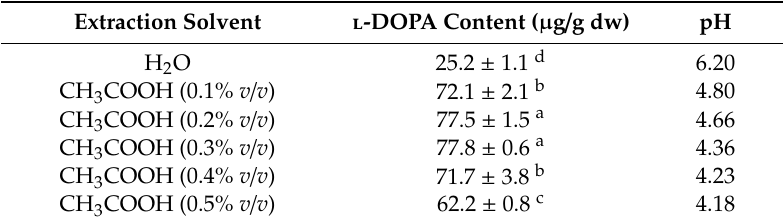
Table 1. Efficiency of L -DOPA extraction A from dry beans of V. faba var. major “Bachus” depending Table 1. E ffi ciency of l -DOPA extraction A from dry beans of V. faba var. major “Bachus” depending on on the solvent and pH of the obtained extracts. the solvent and pH of the obtained extracts.